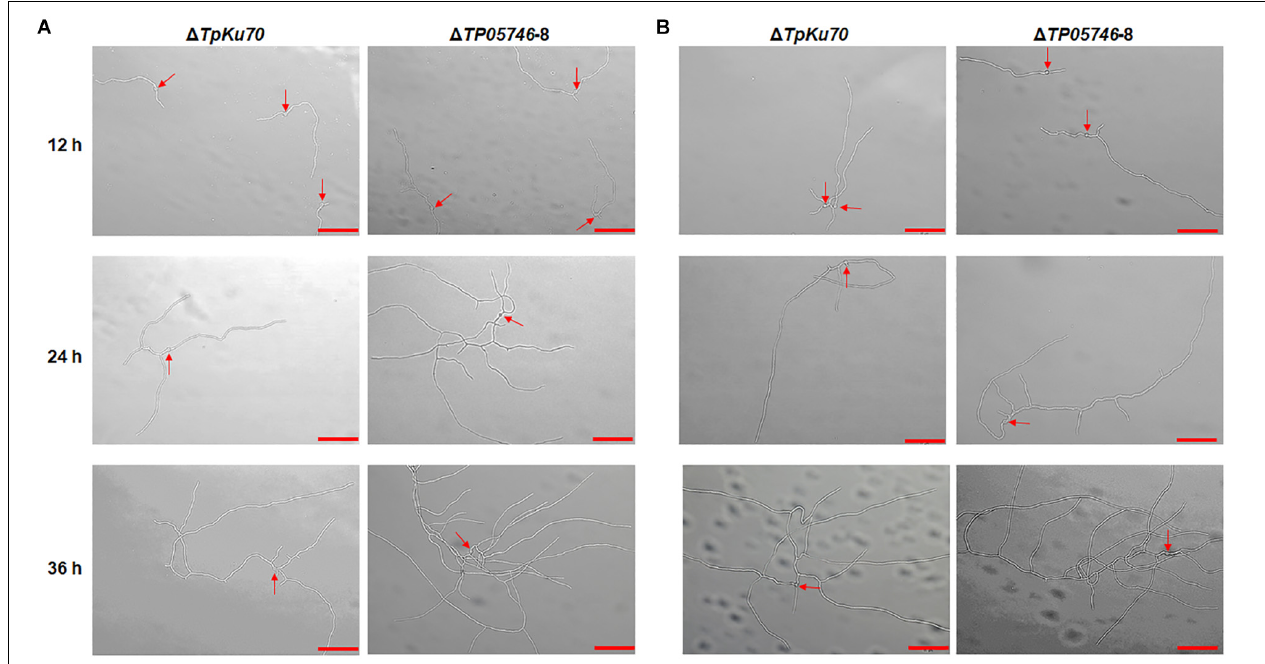
FIGURE 5 | Microscopic investigation of growth of T. pinophilus mutant (cid:49) TP05746 and the parental strain (cid:49) TpKu70 on SLM containing SCS (A) or WA (B) . Fungal strains were cultured at 28 ◦ C for 12–36 h. The mutant (cid:49) TP05746 cultured on SCS or WA for 24–36 h showed more hyphal branches than that of the parental strain (cid:49) TpKu70 . Red arrows indicate the developing conidia. Bar is 50 µ m. SLM, standard liquid medium; SCS, soluble corn starch; WA, wheat bran plus